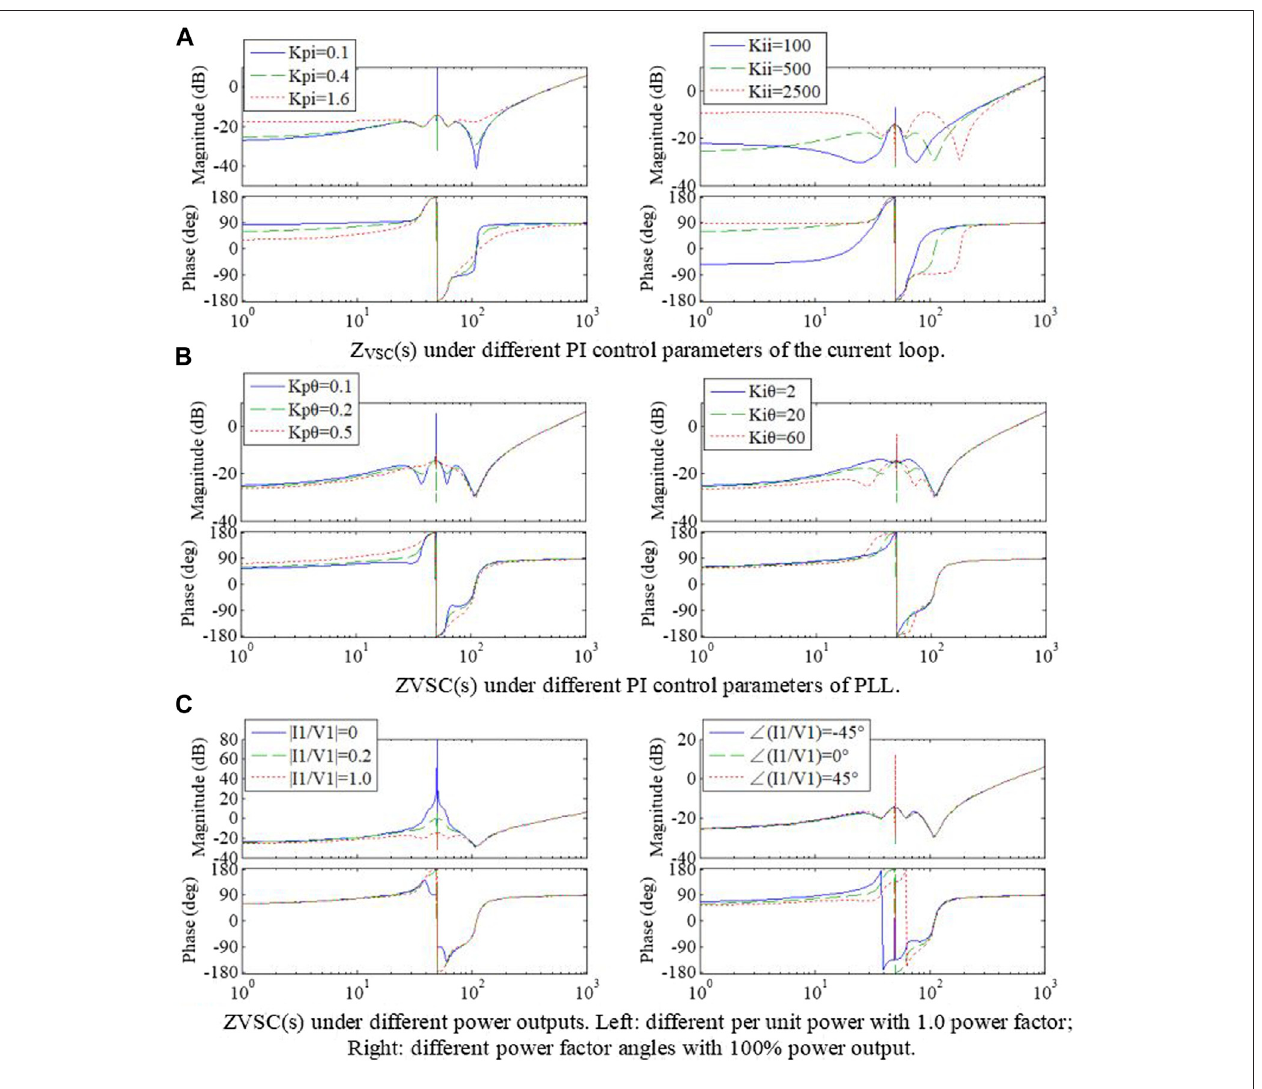
FIGURE 5 | Bode diagrams of the impedance model of a single VSC under different control parameters and operating points. X -axis in Hz. (A) Z VSC (s) under differentPIcontrolparametersofthecurrentloop. (B) ZVSC(s)underdifferentPIcontrolparametersofPLL. (C) ZVSC(s)underdifferentpoweroutputs.Left:differentper unit power with 1.0 power factor; Right: different power factor angles with 100% power output.